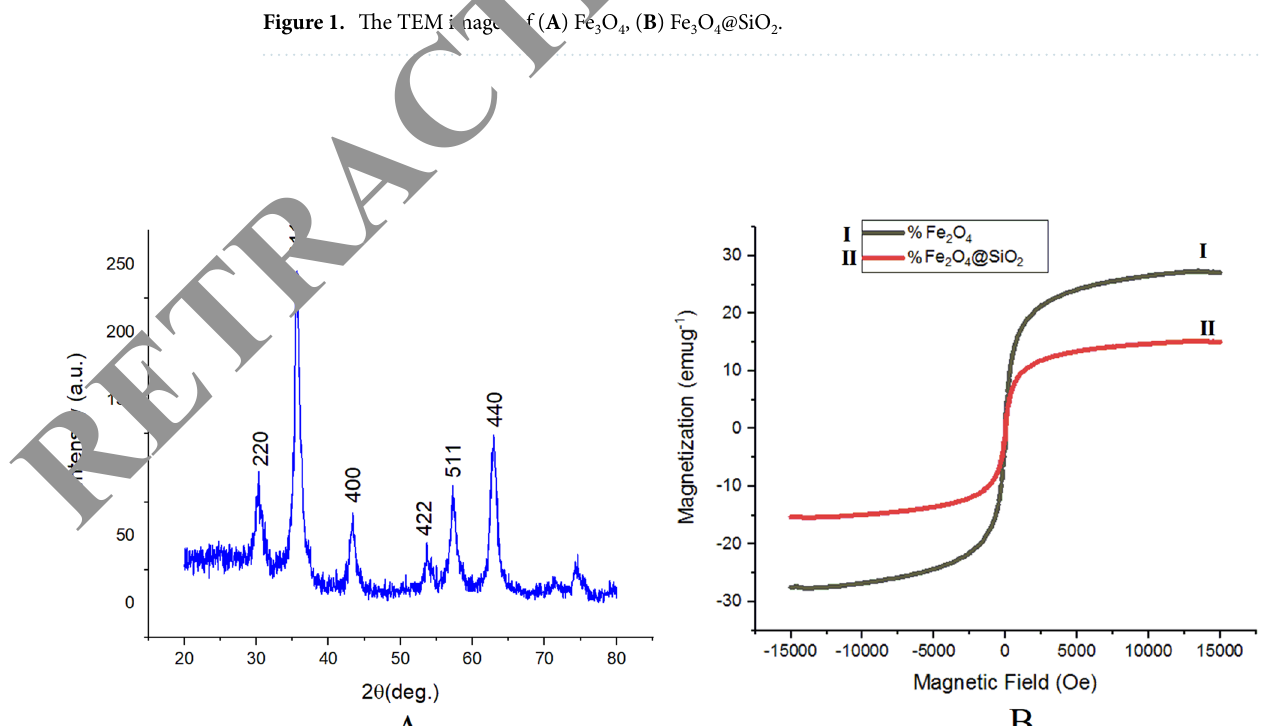
Figure 1. The TEM images of ( A ) Fe 3 O 4 , ( B ) Fe 3 O 4 @SiO 2 .